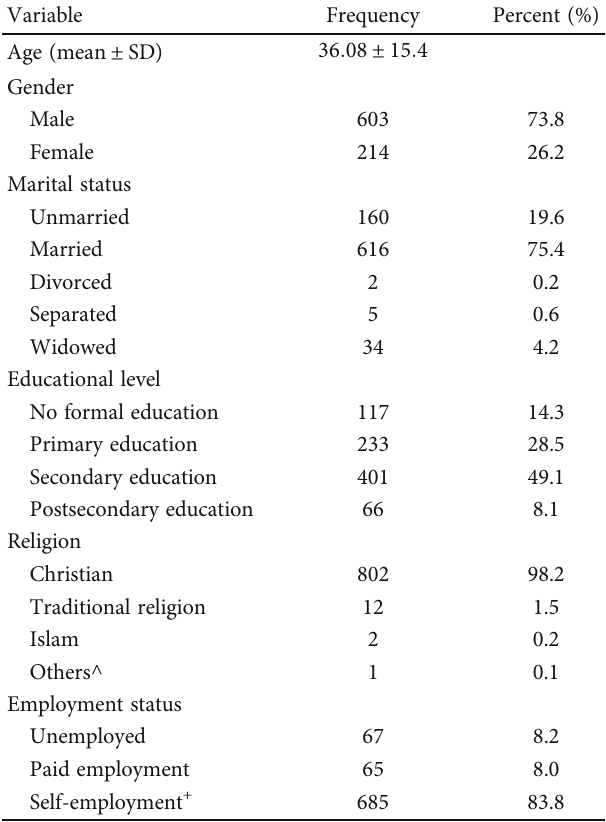
Table 1: Socio-demographic characteristics of community members in Ebonyi, Nigeria ( n = 817